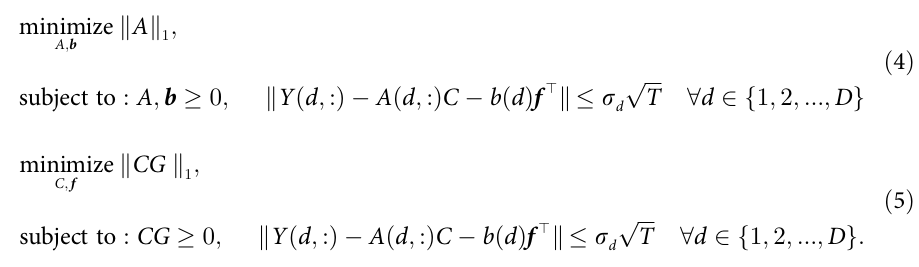
Algorithm 1 is a constrained version of fast HALS. To further improve on fast HALS,